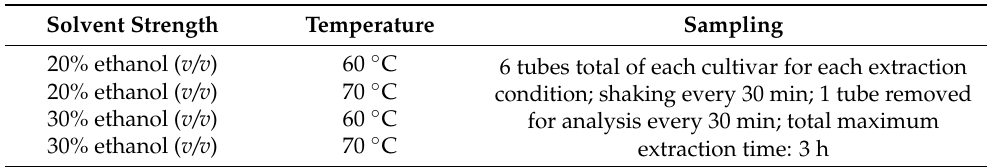
Table 1. Extraction conditions and sampling protocol to identify the preferred solvent strength, temperature, and time of